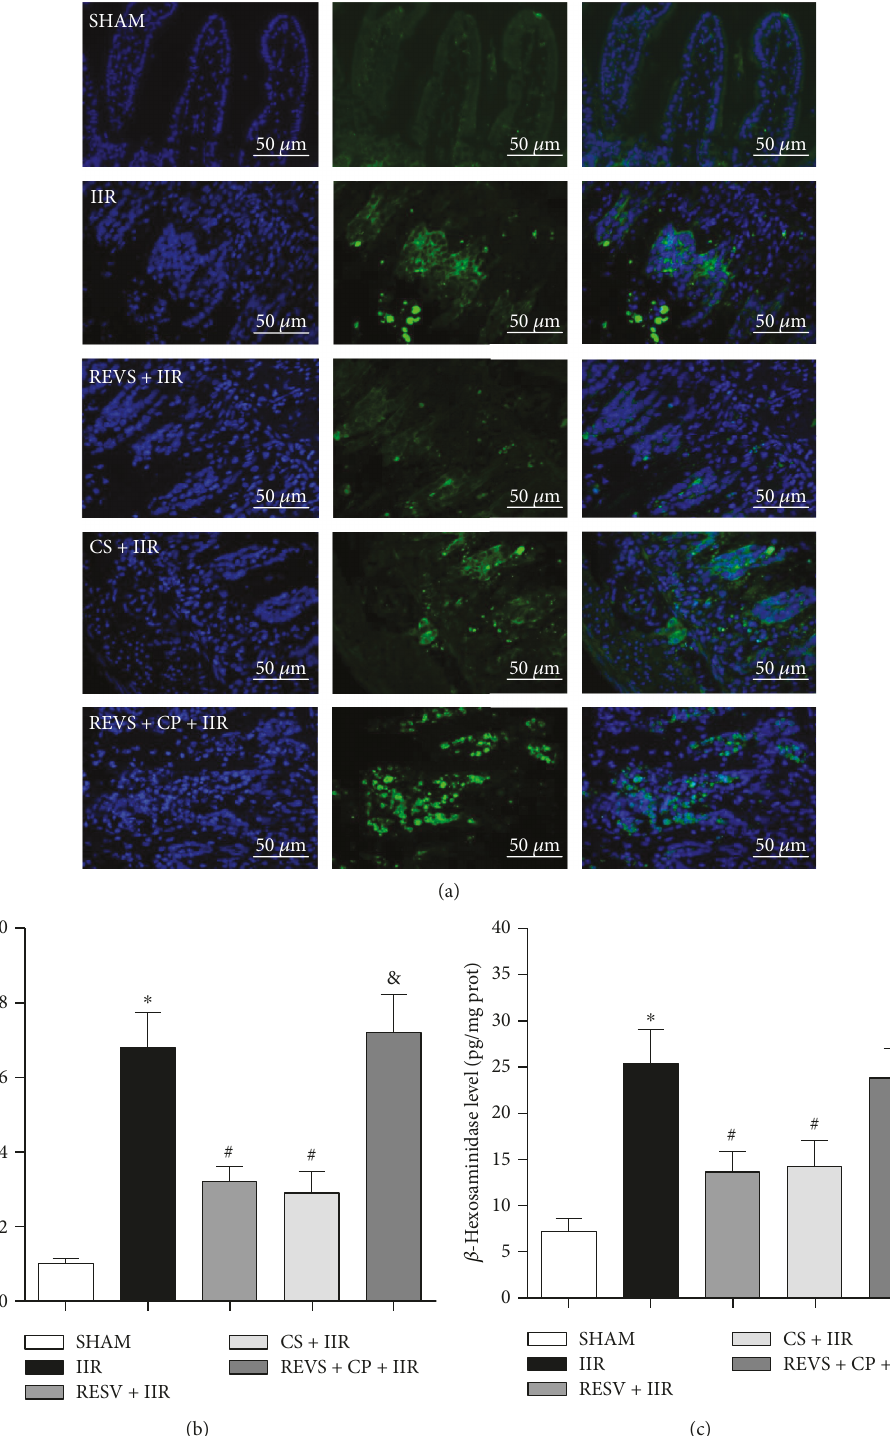
Figure 2: Resveratrol pretreatment stabilized mast cell activation. (a) Representative histological results for each group, tryptase immuno fl uorescence staining, magni fi cation × 400. (b) Tryptase immuno fl uorescence staining gray value. (c) Intestinal β -hexosaminidase activity. IIR: intestinal ischemia-reperfusion; RESV: resveratrol; CP: compound 48/80; CS: cromolyn sodium. Data are expressed as the means ± SEM, n = 8 /group. ∗ P < 0 05 vs. sham group, # P < 0 05 vs. IIR group, & P < 0 05 vs. RESV +IIR